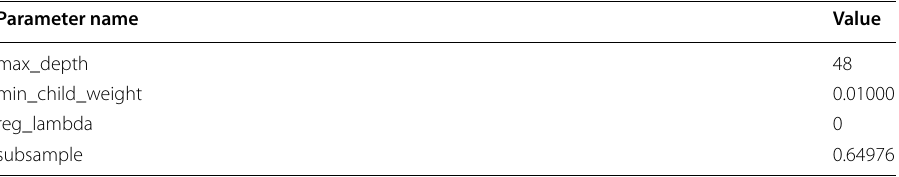
Table 78 Modes of XGBoost tuned hyperparameter values for experiments with the data exfiltration dataset